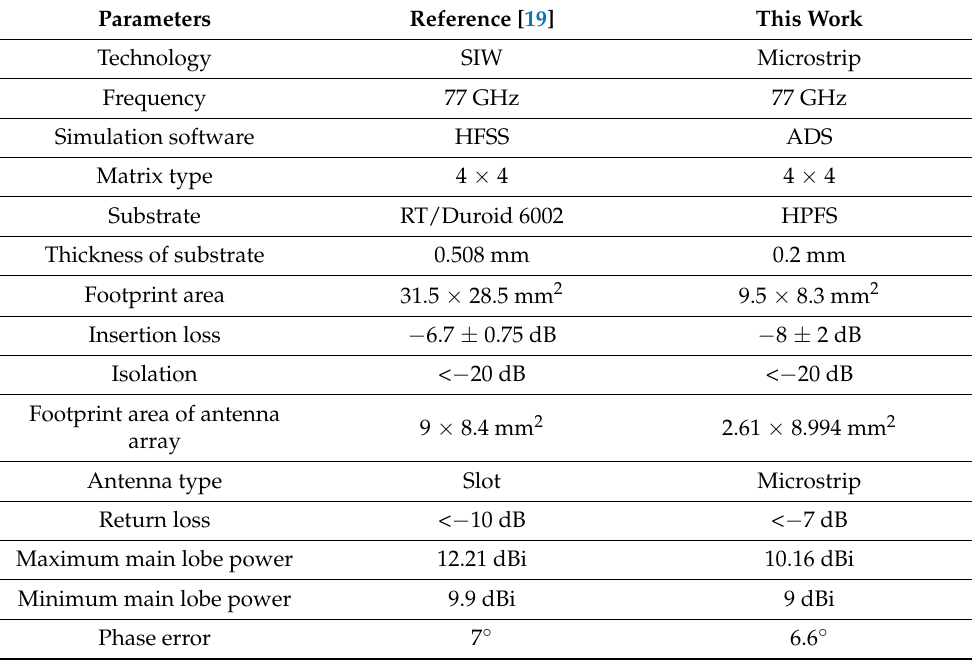
Table 11. Performance comparison of the designed 77 GHz, 4 × 4 Butler